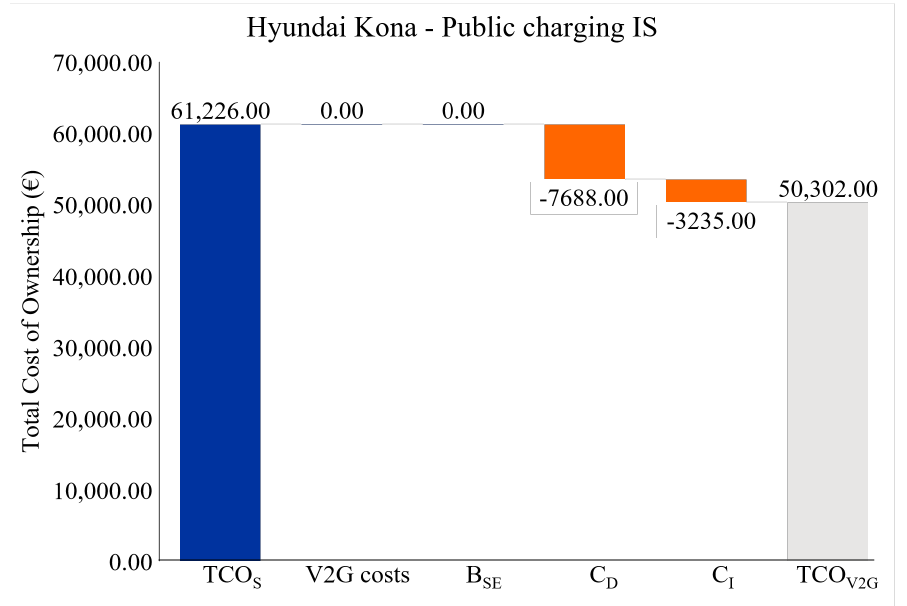
Figure A12. Standard and V2G TCO of a Hyundai Kona in a public charging case providing IS ( TCO S = Standard TCO, B SE = benefit of saved electricity costs from the grid, C D = direct compensa- tion, C I = indirect compensation, TCO V 2 G = V2G TCO); source: own compilation).